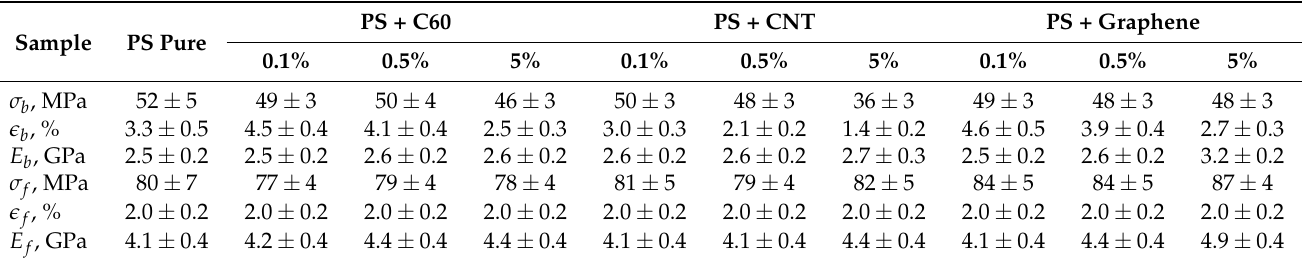
Table 1. Linear elastic parameters of PS-based nanocomposites obtained from tensile and three-point bending tests.